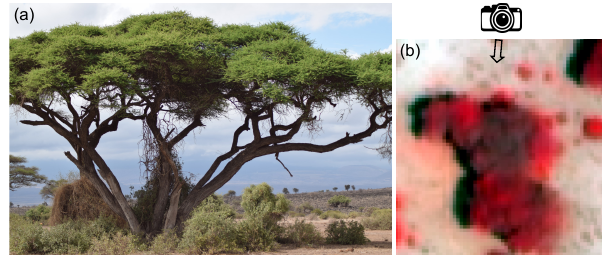
Figure A4. Vachellia tortilis at a field work site in Amboseli NP, Kenya. Panel (a) shows two trees with overlapping crowns, with the second being further back on the left. Panel (b) shows the same trees in false-color satellite imagery. The spread-out architecture of the canopy makes them appear as several distinct crowns. The camera symbol roughly indicates the position from which the ground photo was